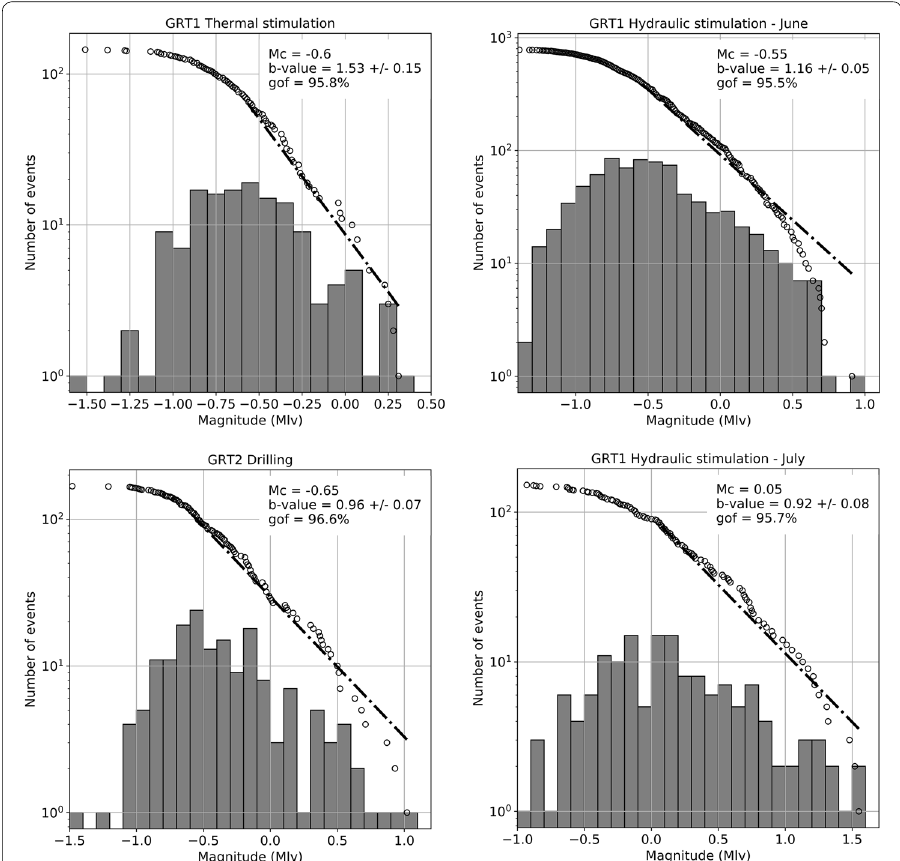
Fig. 12 Frequency–magnitude distribution of induced earthquakes: cumulative number (black circles) and histogram (gray bars), and an estimate of the magnitude of completeness and b-values. The results are given for the GRT-1 thermal stimulation (top left), GRT-2 drilling (bottom left), GRT-1 hydraulic stimulation— June (top right) and July burst (bottom right). The axis scales are different among the